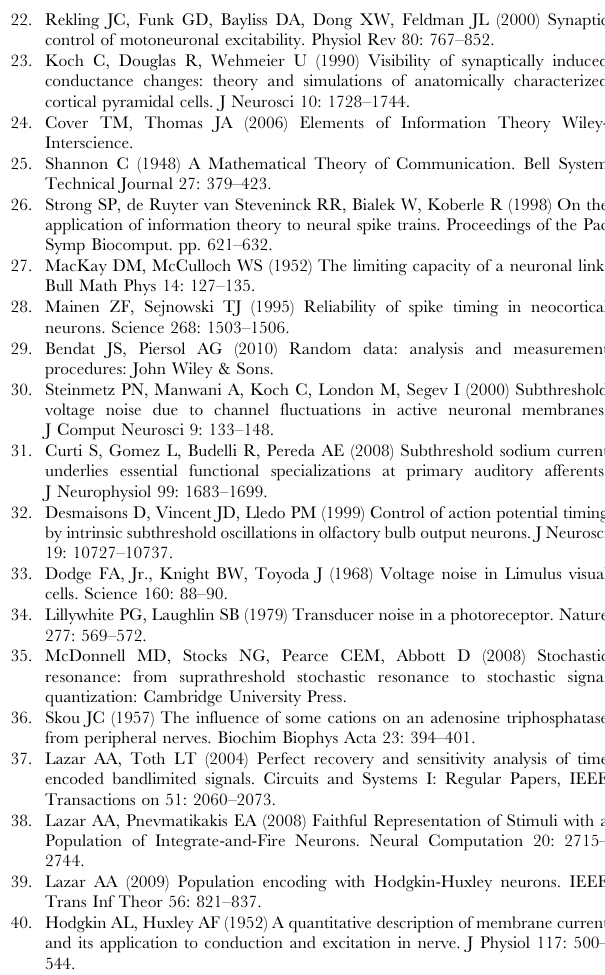
Figure S7 The numbers of open K + channels and the membrane potential range determines the energy consumption of graded potentials. A. Joint kernel density estimates of open K + channels and the membrane potential in response to low mean, low standard deviation stimulus, and B. low mean, high standard deviation stimulus. C. Joint kernel density estimates of open K + channels and the membrane potential in response to high mean, low standard deviation stimulus, and D. high mean, high standard deviation stimulus. Figure S8 The gating scheme for the voltage-gated ion channels. A. State transition diagram for Na + channel. B. State transition diagram for K + channel. Table S1 Parameters for the stochastic Hodgkin-Hux- ley